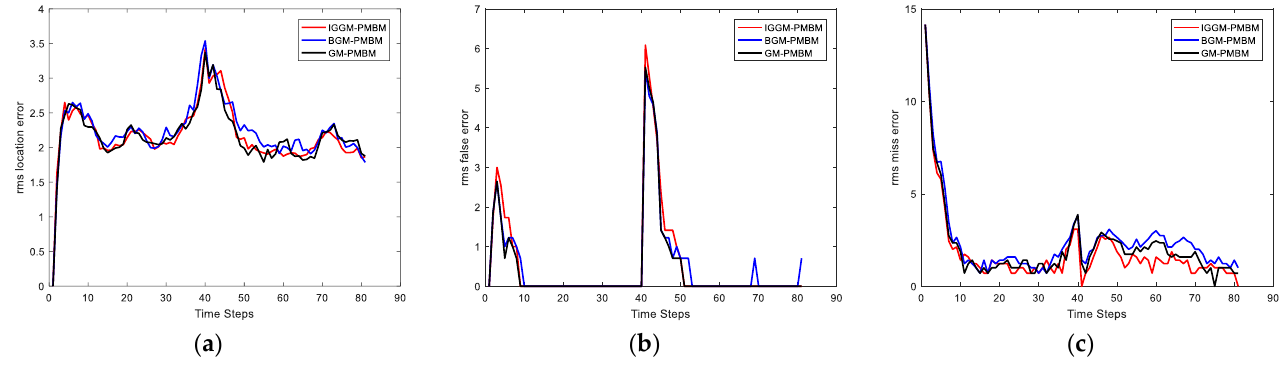
Figure 6. The average of estimated detection probability in 100 Monte Carlo runs. ( a ) P D = 0.94, λ κ = 10; ( b ) P D = 0.68, λ κ = 10.